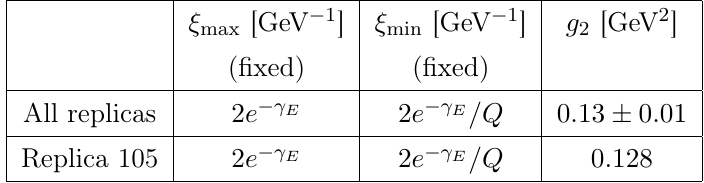
Table 10 . Values of parameters common to TMD PDFs and TMD